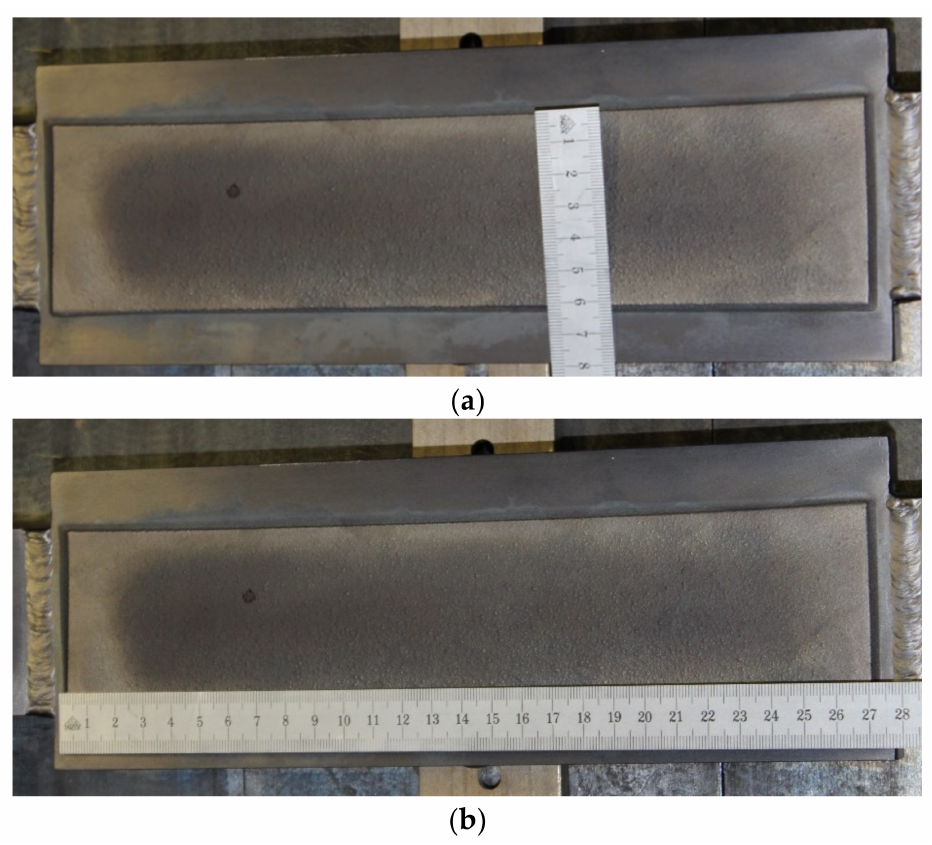
Figure 13. Status of the heat-loaded FG mock-up surface after the testing, the flow direction in the channels being from right to the left. The dark area in the center of the picture indicates the zone subject to high-heat flux loading: ( a ) transverse measurement of the FG-layer and of the loaded area; ( b ) measurement of the longitudinal dimensions of the FG-layer and the loaded